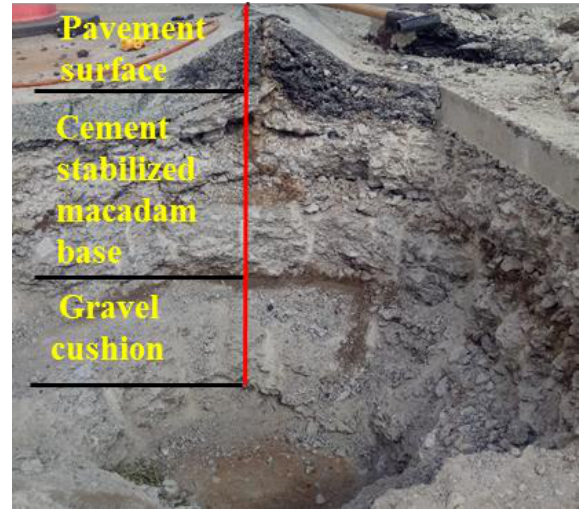
Figure 1. Pavement structure at the arch expansion section.